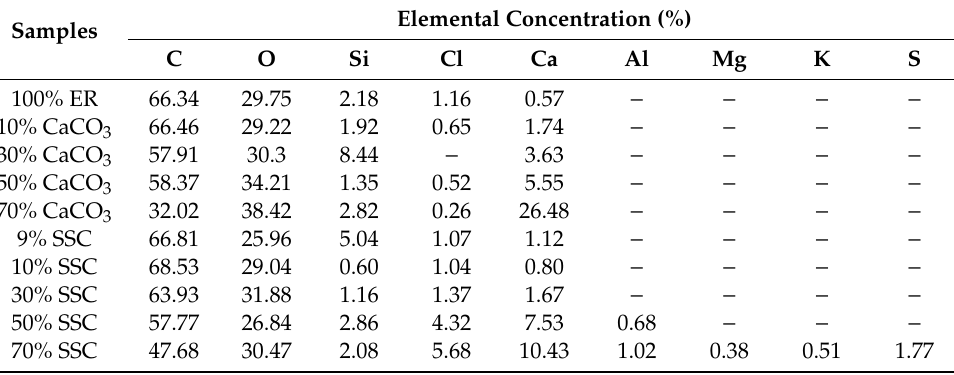
Table 3. Chemical characterization by SEM analysis of epoxy resin (ER), CaCO 3 -composite (CaCO 3 ) and stabilized sample-composite (SSC).